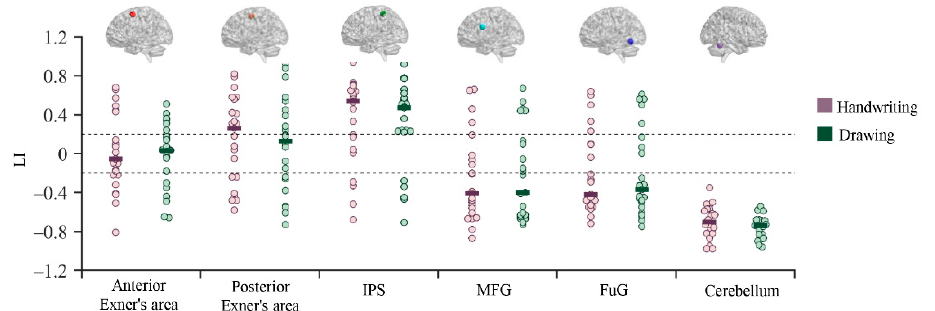
Figure 3. Activation lateralization values of each ROI during handwriting and drawing. Each dot represents one participant, and the short dark line represents the median value. The upper and lower dotted lines correspond to lateralization values of − 0.2 and 0.2, respectively. IPS = inferior parietal sulcus, MFG = middle frontal gyrus, FuG = fusiform gyrus.